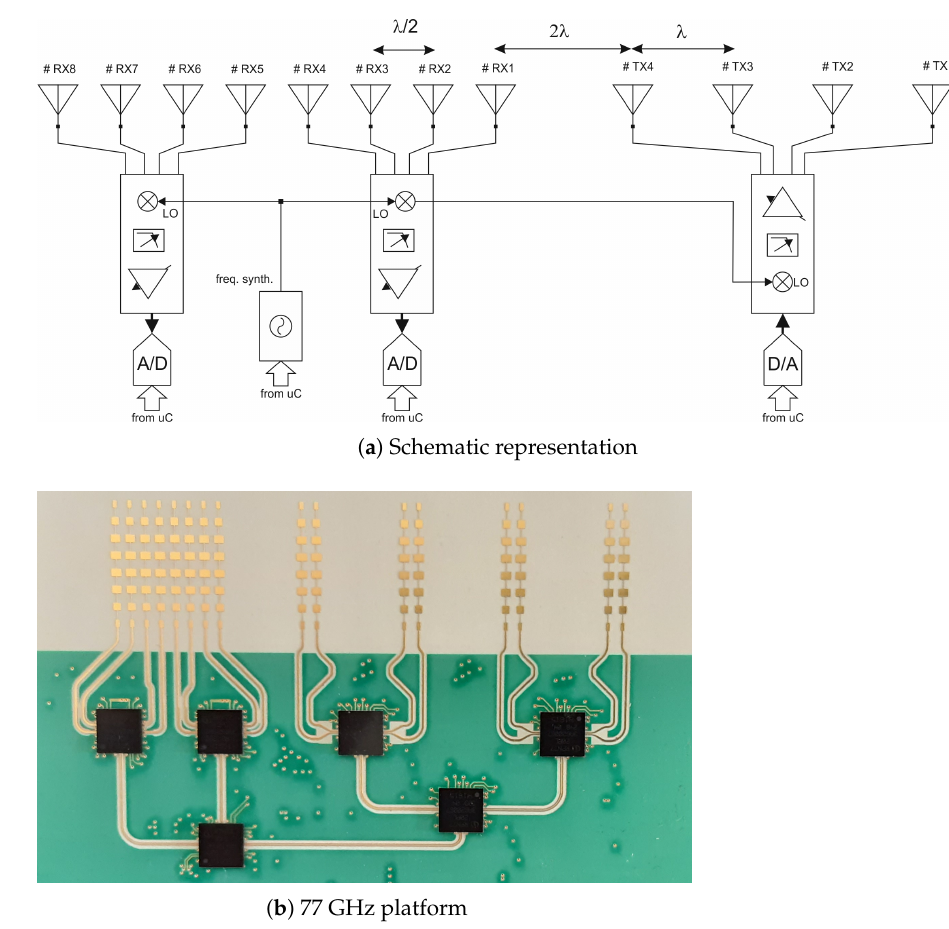
Figure 2. Architecture of the millimeter frequency-modulated continuous-wave (FMCW) multi-input multi-output (MIMO) radar adopted for the experimental